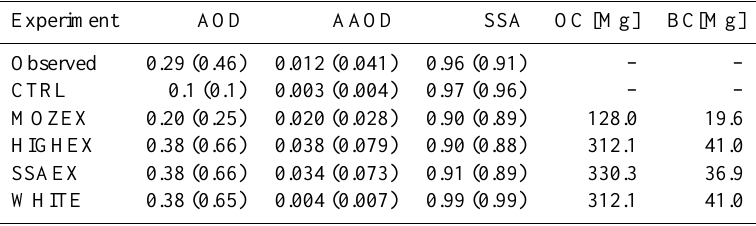
Table 2. Land area-averaged (3 ◦ N–37 ◦ S, 19 ◦ W–50 ◦ E) aerosol optical depth (AOD), aerosol absorption optical depth (AAOD), and single scattering albedo (SSA) for each experiment and the EP -TOMS/AERONET observationally-based maps from Figure 1 a-c (Observed). Here AAOD = AOD × (1 − SSA). Land area-averages for the main biomass burning region (7 ◦ S–17 ◦ S, 11 ◦ E–29 ◦ E) are given in parenthesis. ASO total mass loading of BC and OC for each experiment over land for the entire region (3 ◦ N–37 ◦ S, 19 ◦ W–50 ◦ E) is also given. Recall that CTRL does not have BC or OC. Experiment AOD AAOD SSA OC [Mg] BC[Mg] Observed 0.29 (0.46) 0.012 (0.041) 0.96 (0.91) – – CTRL 0.1